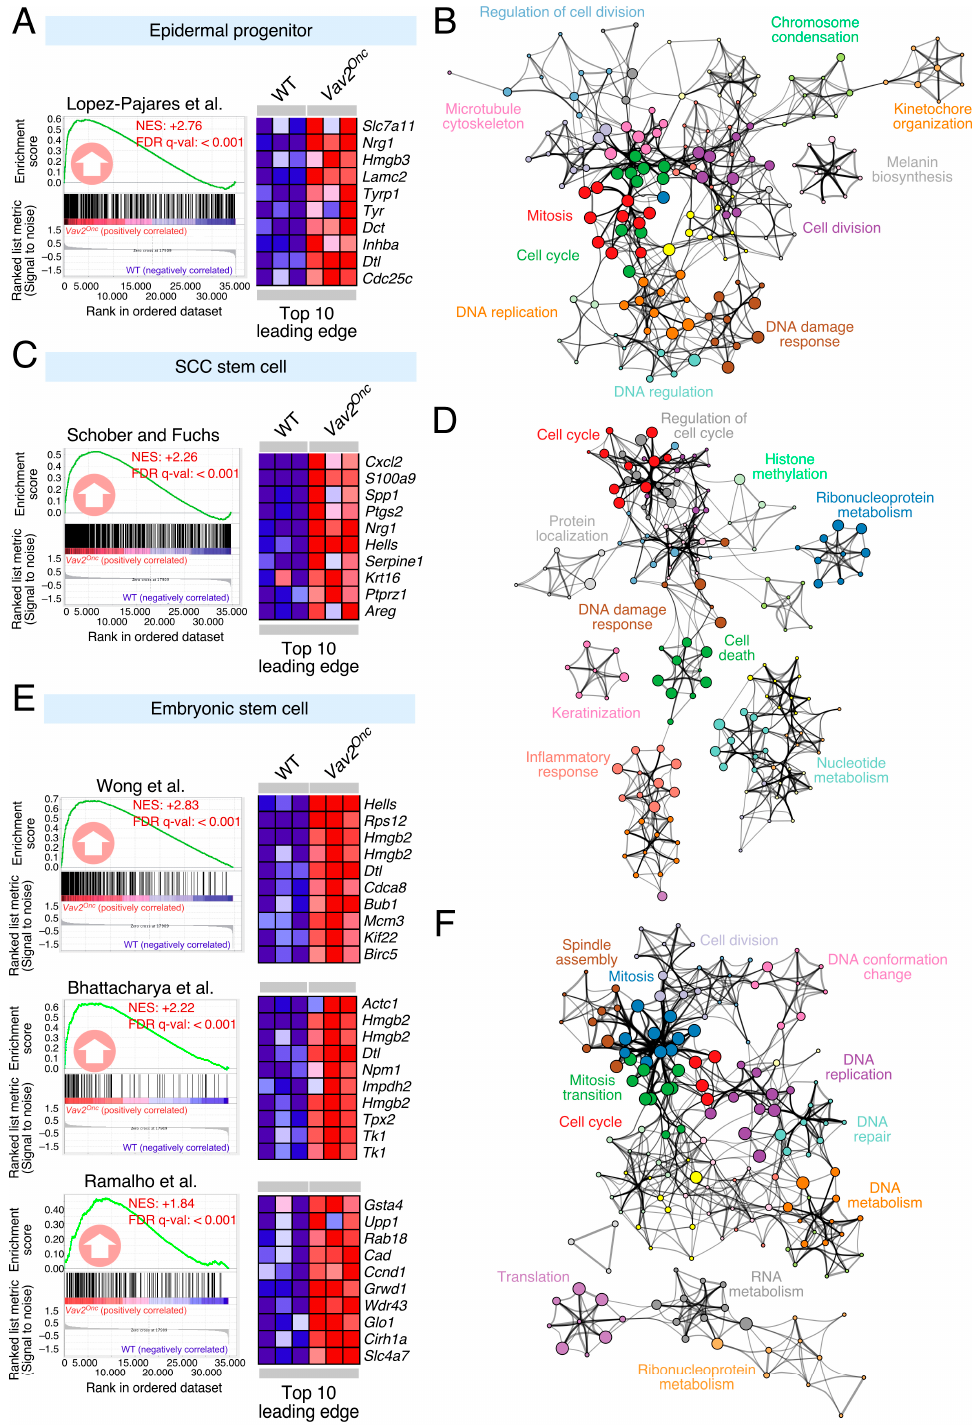
Figure 1. VAV2 controls a stem cell-like transcriptional program in keratinocytes. ( A,C,E ) Gene Set Enrichment Analyses (GSEA) of the indicated gene sets (top) in the Vav2 Onc -dependent skin transcriptome. The normalized enrichment scores (NES) and false discovery rate q -values (FDR q -val) are indicated within each graph. Positive enrichments are indicated with upward-pointing arrows. The expression heatmap for the top 10 leading-edge probesets is also included. ( B,D,F ) Functional networks depicting the most enriched functional terms in the leading edge of the GSEA shown in A,C,E. Node size is proportional to the significance of the enrichment. Related functional terms are linked by